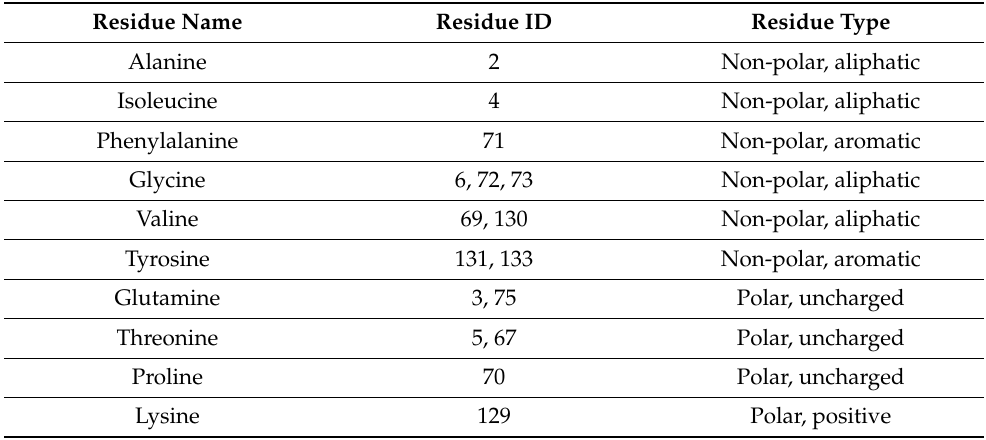
Table 3. Amino acids (residues) of Bacteriorhodopsin adsorbed (within 5 Å) on the surface of Graphene.